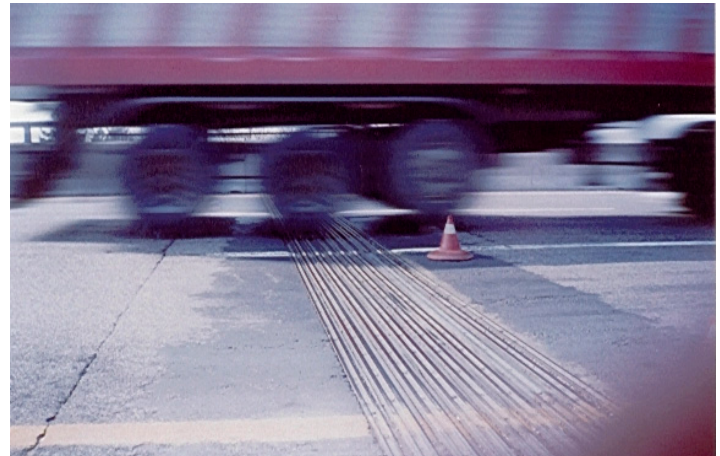
Figure 3. Loss of tire/pavement contact during the passage on the BEJ.